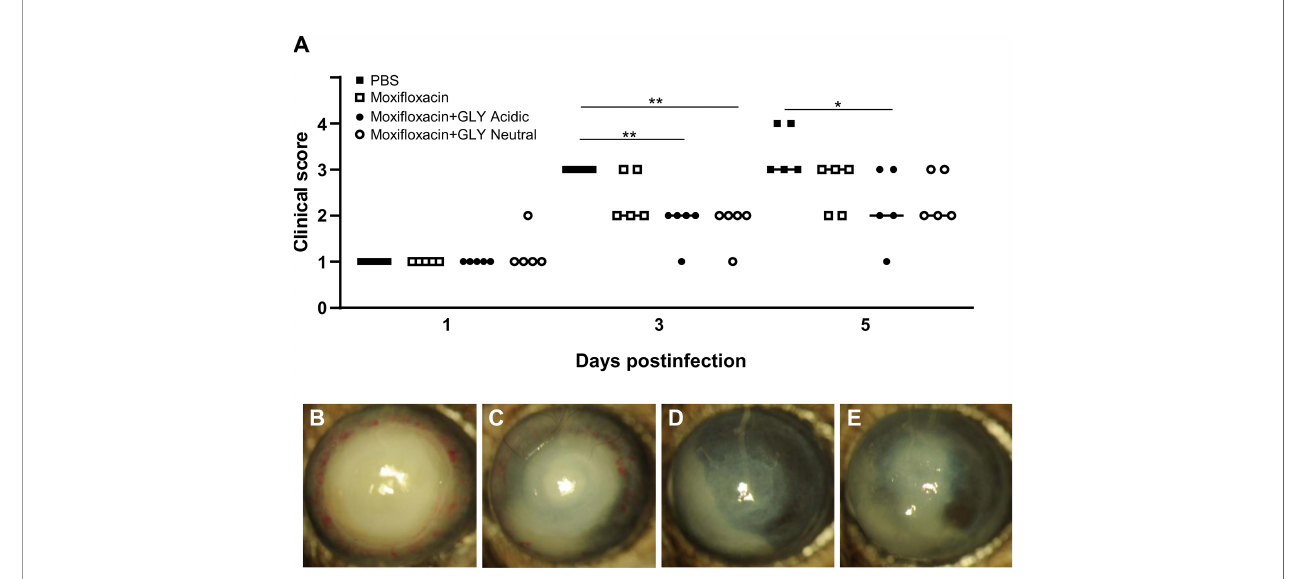
FIGURE 7 | Effects of GLY pH on corneas infected with MDR9. (A) Clinical scores at 1, 3, and 5 days p.i. after treatment with PBS, moxi fl oxacin, and acidic or neutral GLY plus moxi fl oxacin (began 18 h after infection). Similar lower clinical scores were observed at 3 and 5 days p.i. when moxi fl oxacin was combined with either acidic or neutral GLY vs PBS. Slit lamp photographs from PBS (B) , moxi fl oxacin (C) , moxi fl oxacin plus acidic (D) , or neutral (E) GLY-treated corneas at 5 days p.i. show signi fi cantly reduced opacity con fi ned over the pupil, with hypopyon in the anterior chamber in mice treated with moxi fl oxacin together with either acidic or